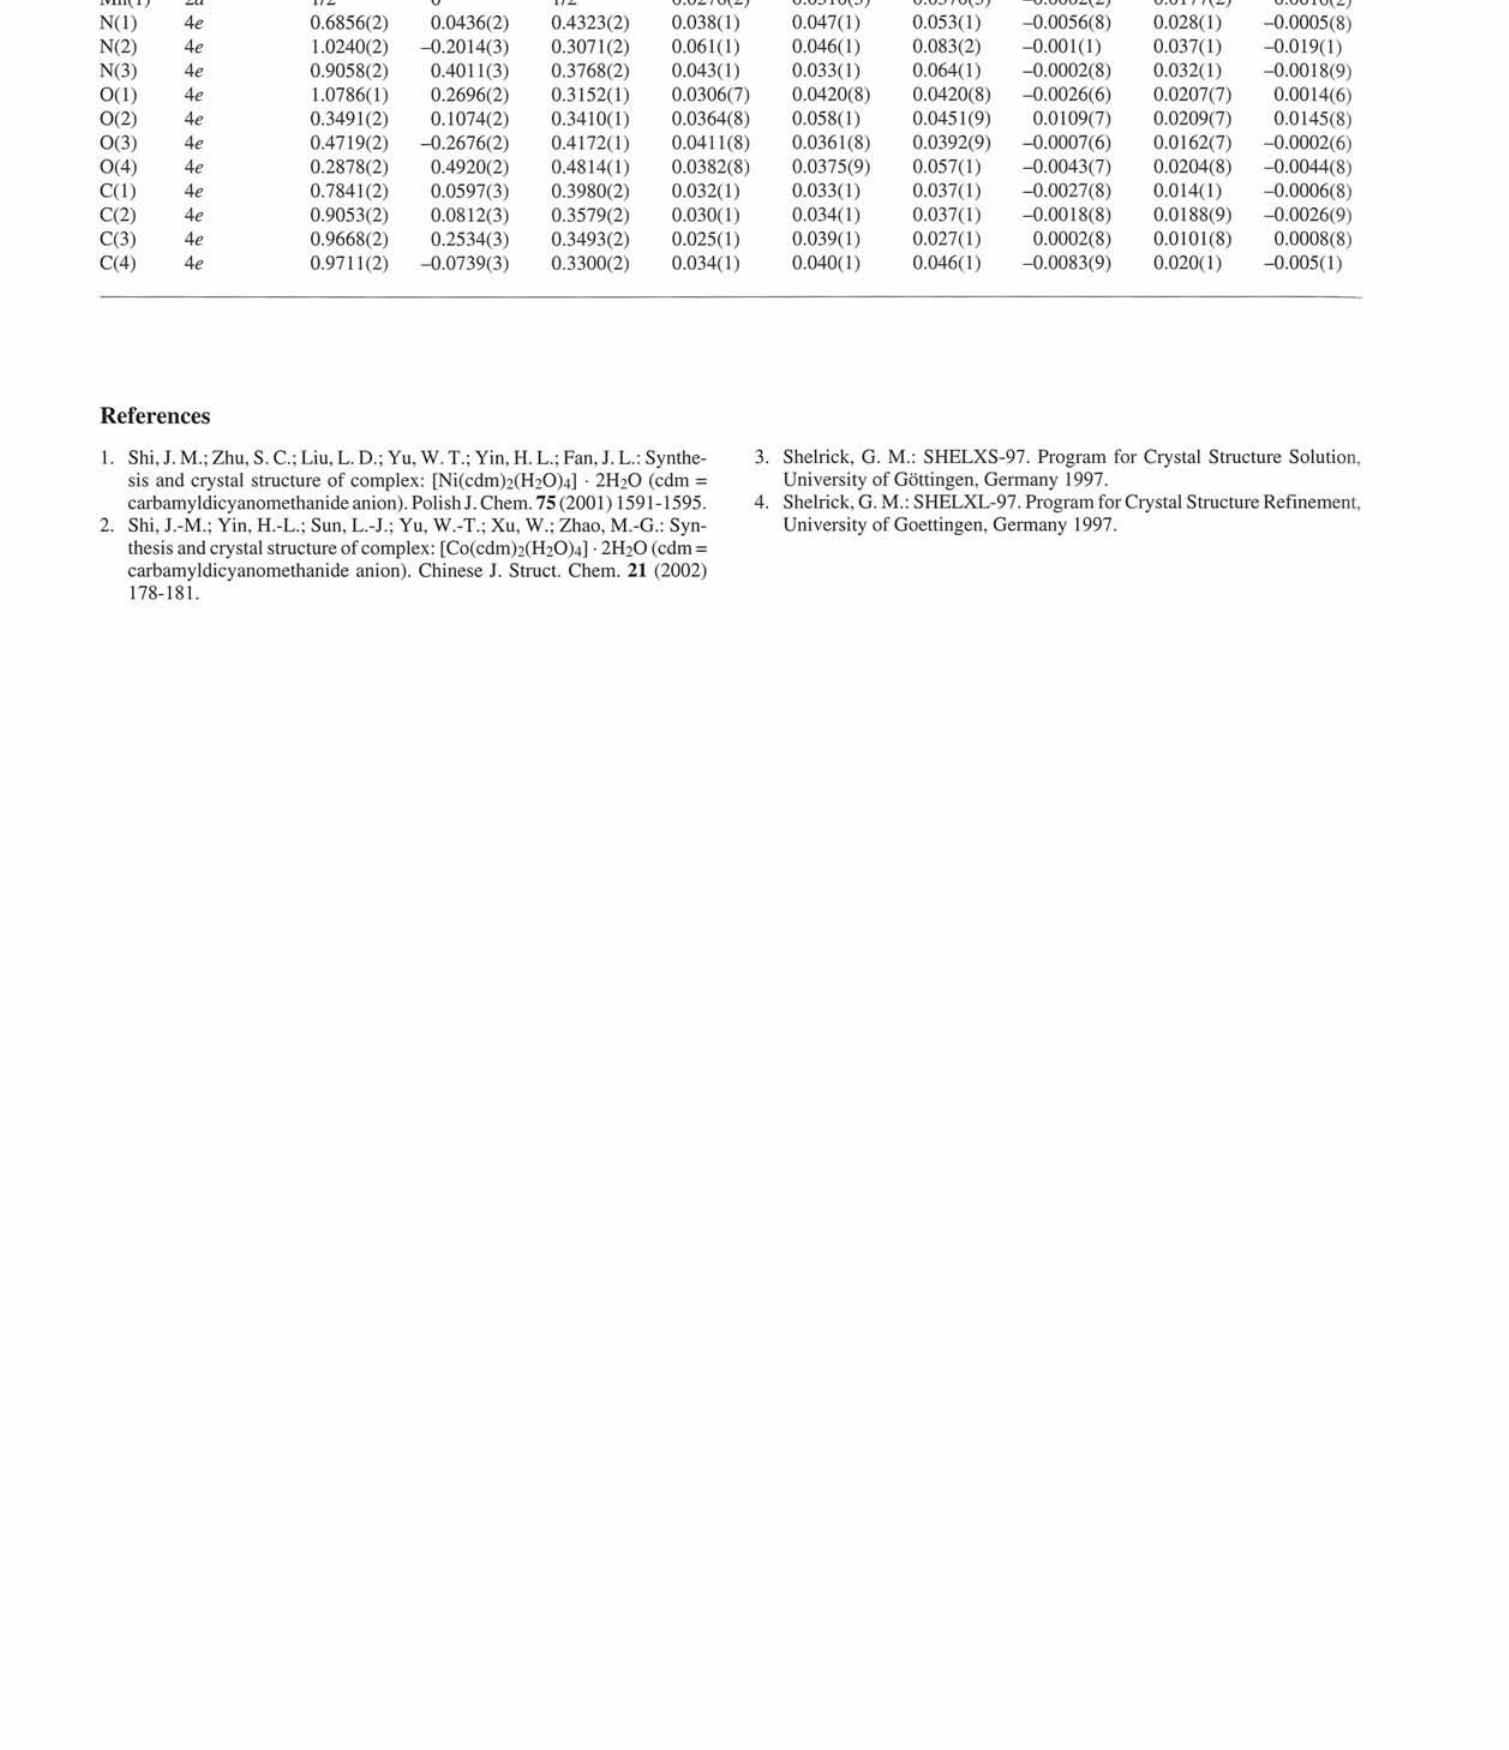
Table 3. Atomic coordinates and displacement parameters (in Â 2